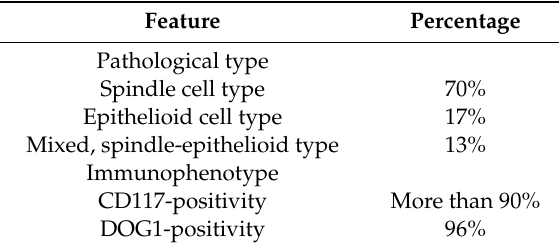
Table 1. Summary of pathological types and immunophenotypes in GISTs.